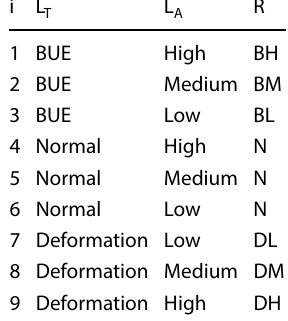
Table 3 Linguistic variables for different fuzzy rules